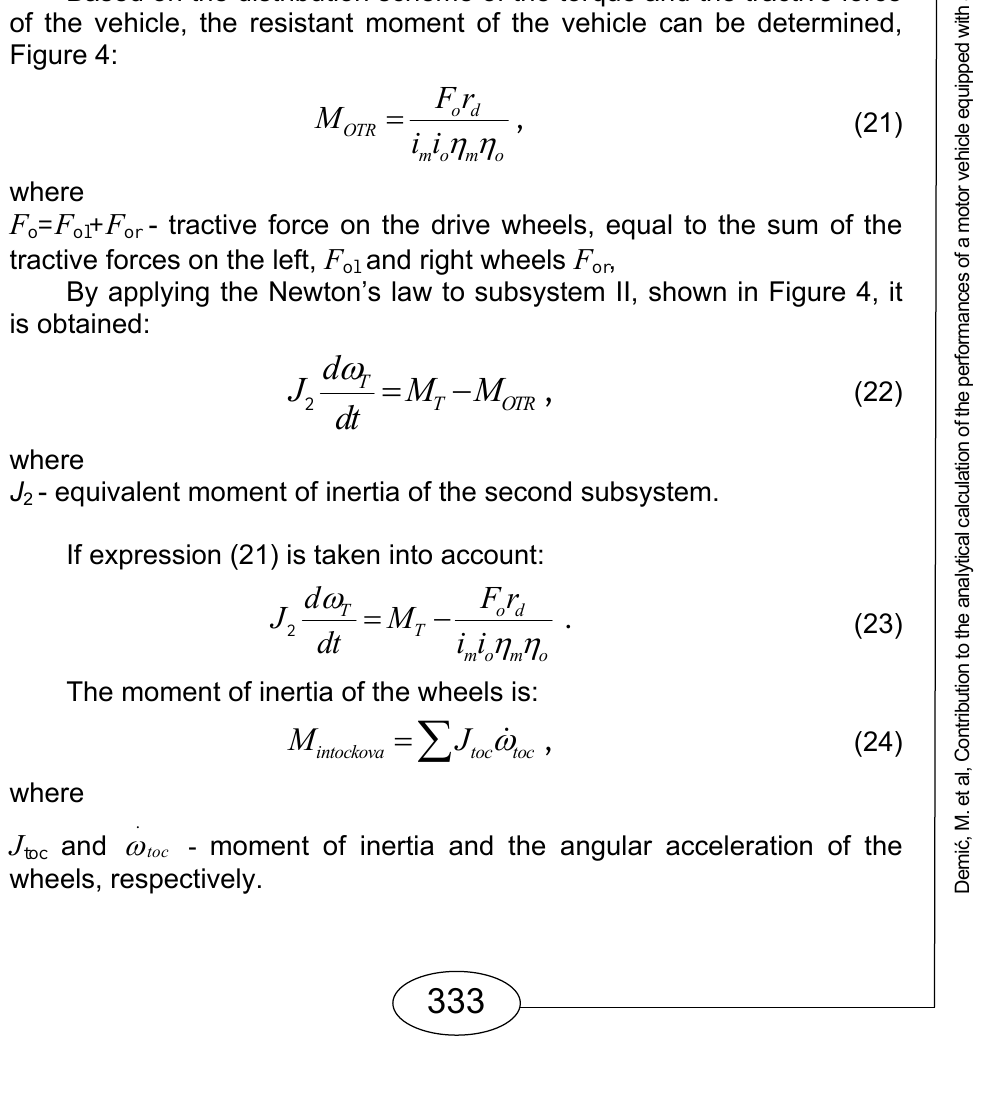
Figure 4 – Subsystem II Рис . 4 – Подсистема II Слика 4 – Подсистем